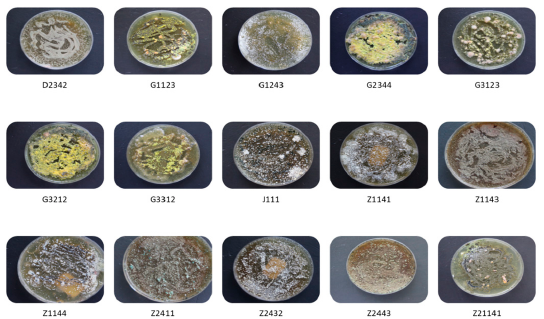
Figure 2. Representative samples of the purified fungal isolates extracted from fire ants, mound soils, and plant debris. Samples were collected across five different cities in Guangdong Province, China.